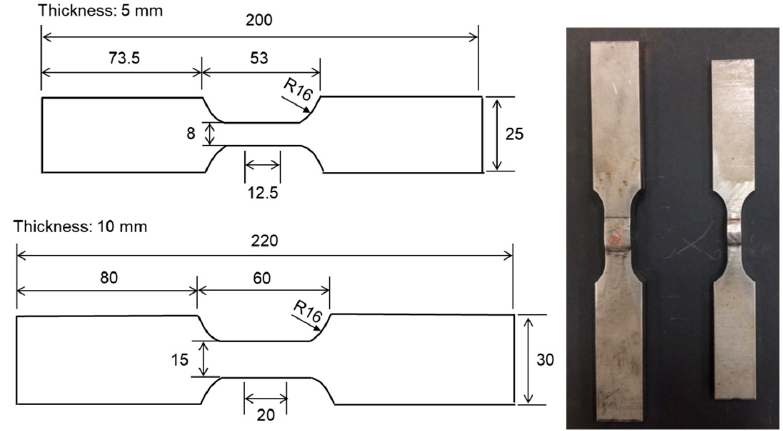
Figure 4. Detailed dimension of the test specimen. Table 3. Low-cycle fatigue (LCF) test conditions.